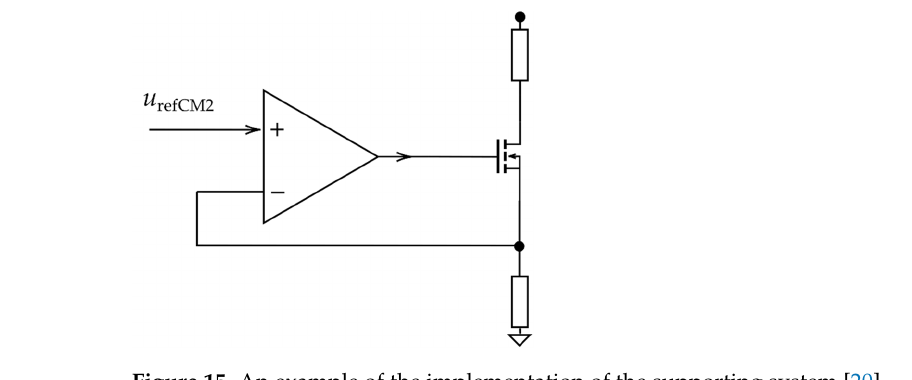
Figure 15. An example of the implementation of the supporting system [20].